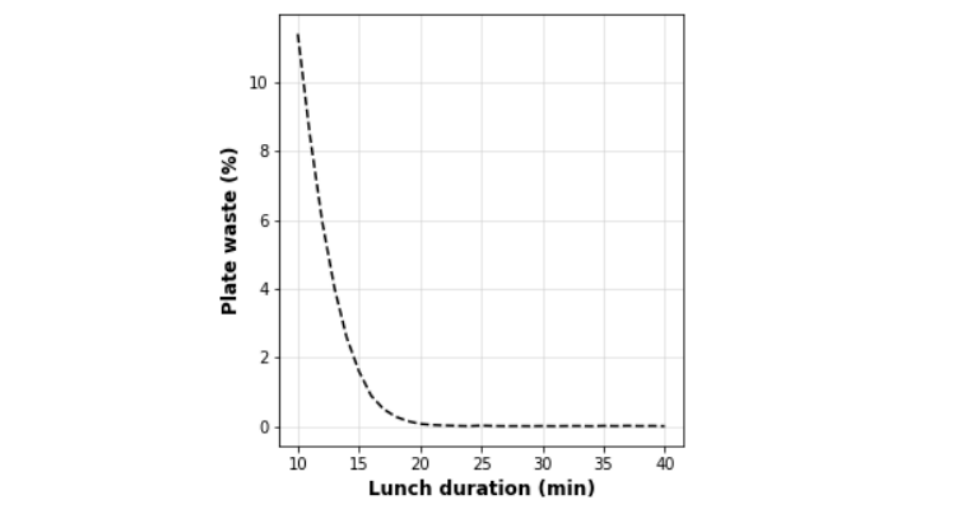
Figure 12. Capability model for effective decision making on food management in schools.